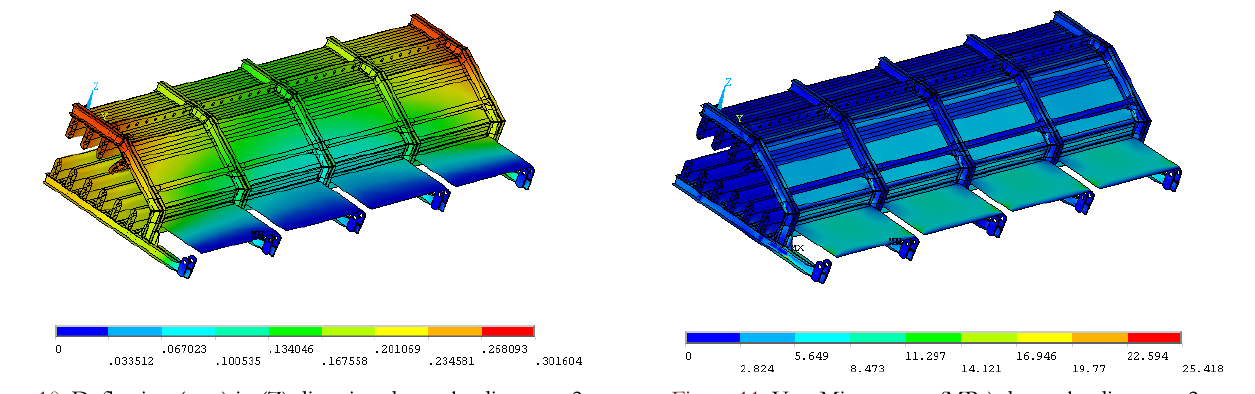
Figure 10: Deflection (mm) in (Z) direction due to loading case 2. Figure 11: Von Mises stress (MPa) due to loading case 2.